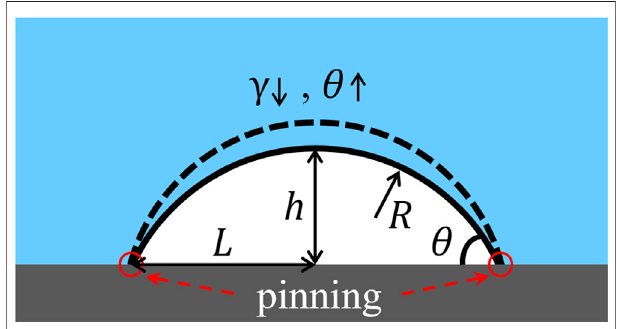
FIGURE 1 | The sketch of a pinned surface nanobubble. θ is the gas- side contact angle, L is the lateral radius, h is the height, R is the radius of curvature, and c is the surface tension of the gas-liquid